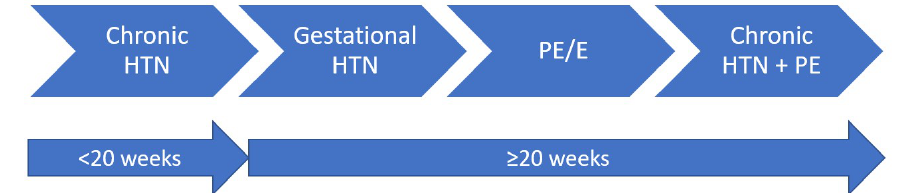
Figure 2. The classification of pregnancy-related hypertensive disorders; HTN = hypertension; PE = pre-eclampsia; E = eclampsia.